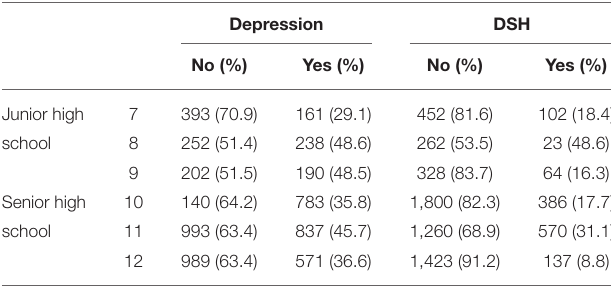
prevalence of DSH (29). TABLE 1 | The changes in depression and DSH in junior high school and senior high school